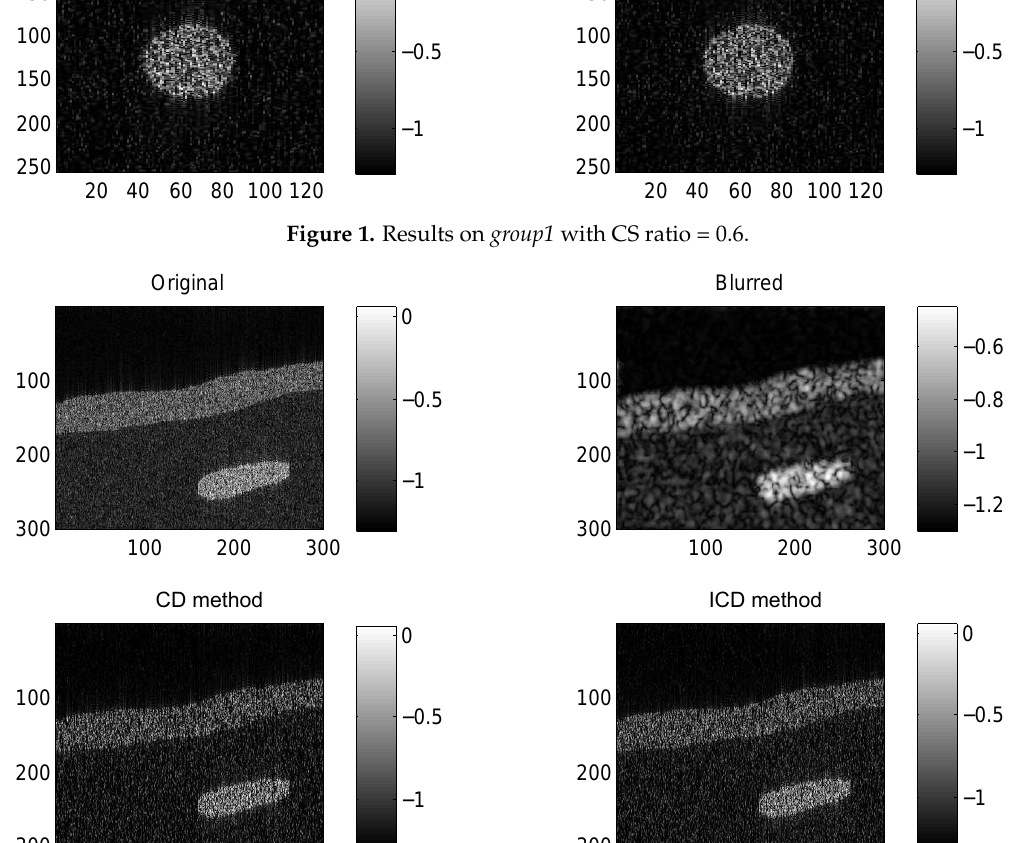
Figure 2. Results on group2 with CS ratio =